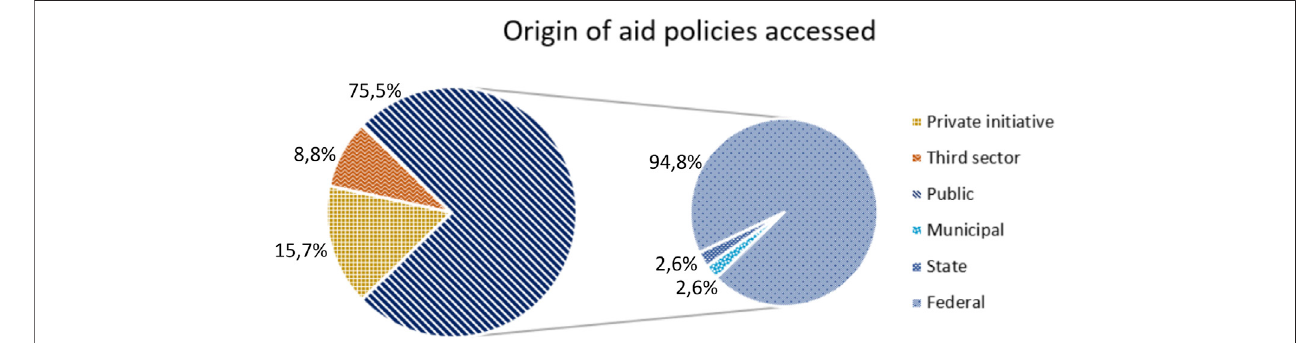
FIGURE 5 | Origin of aid policies accessed.